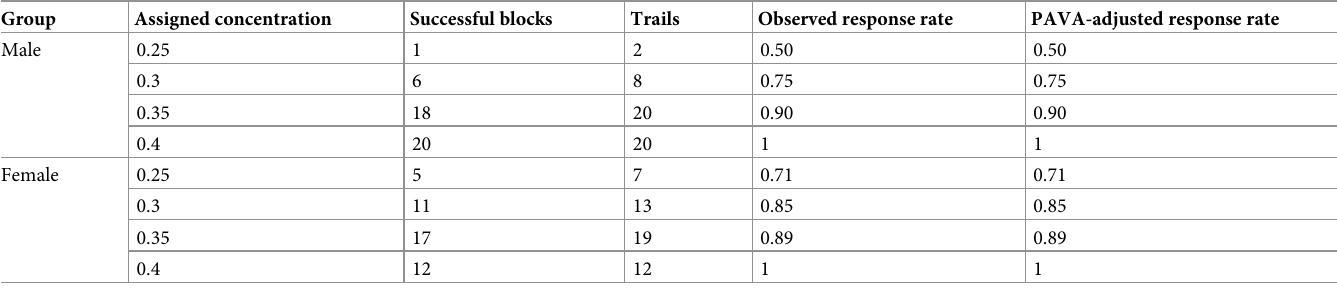
Table 2. Observed and pooled-adjacent violators algorithm-adjusted response rates.